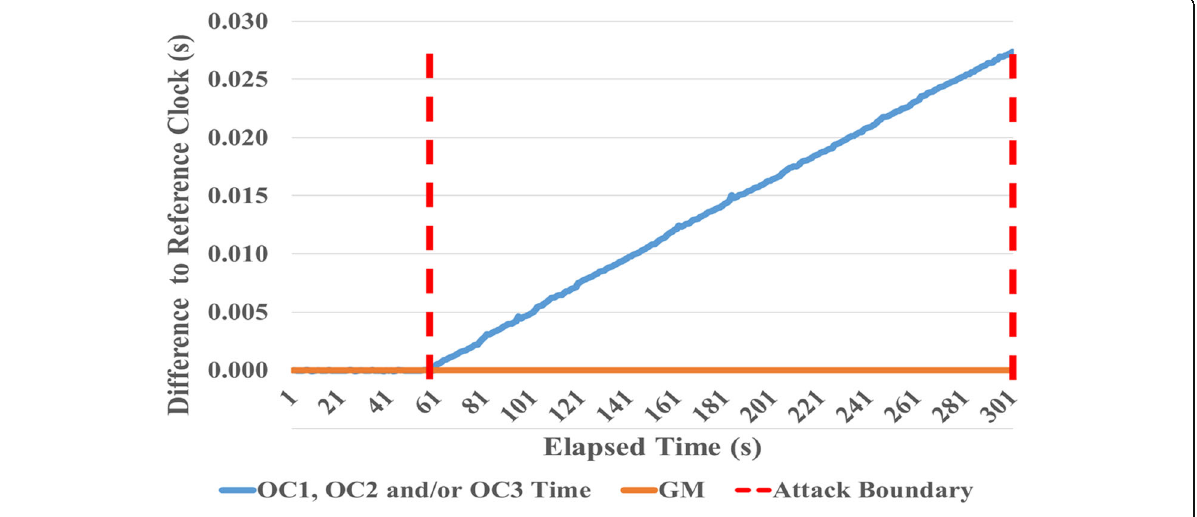
Fig. 5 Impact of packet content manipulation